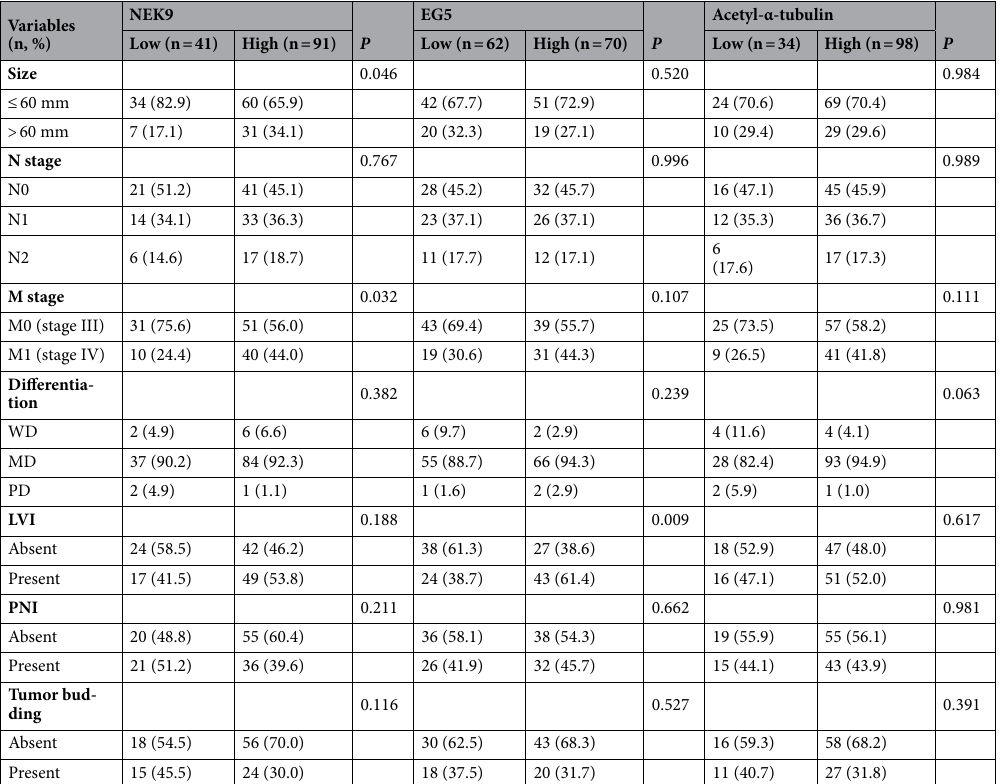
Table 1. Immunohistochemical expression of NEK9, EG5 and acetyl-α-tubulin and clinicopathologic characteristics. WD well differentiated, MD moderately differentiated, PD poorly differentiated, LVI lymphovascular invasion, PNI perineural